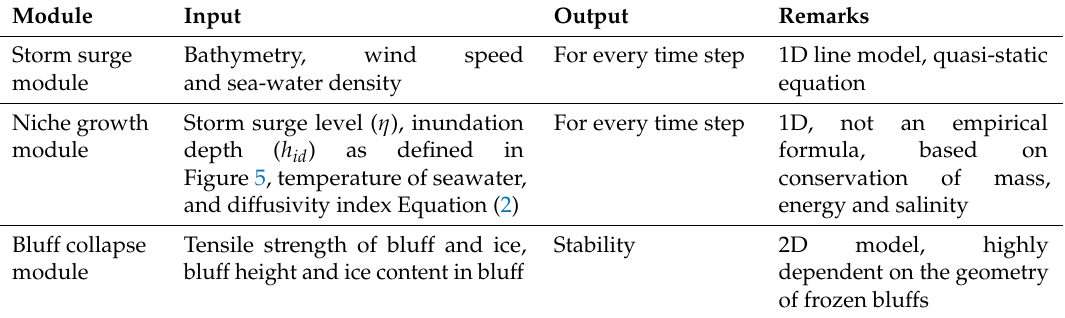
Figure 7. Algorithm of the model with three numerical modules and Monte Carlo simulation. Table 2. Major input and output parameters of the three